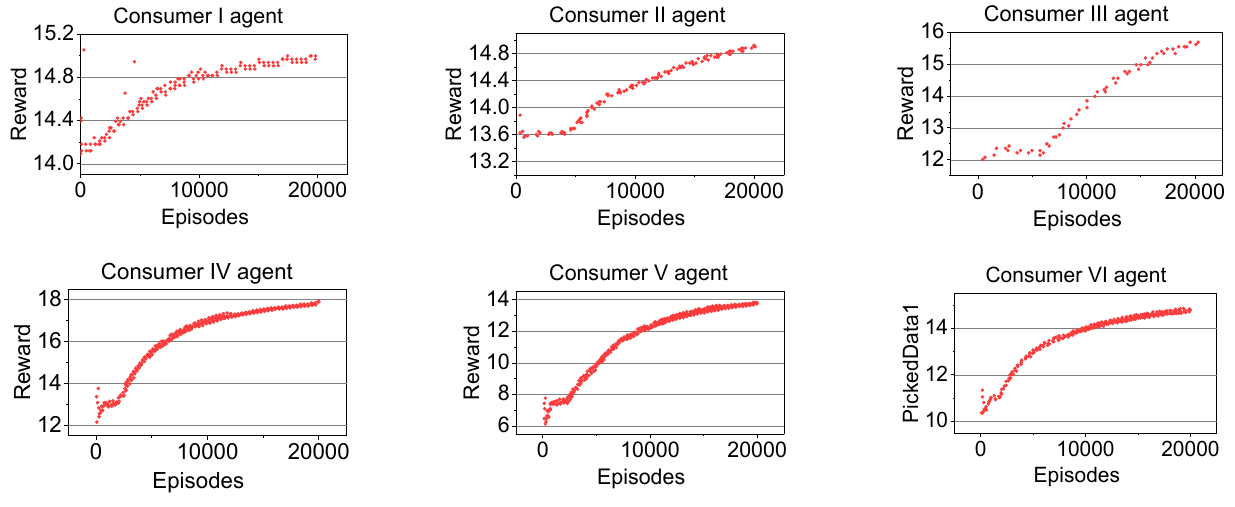
Figure 13. The training process of each DDPG agent.